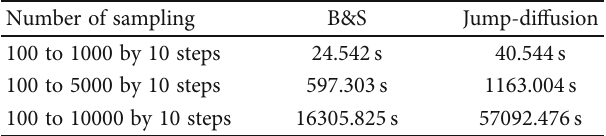
Table 2: Time consumption (MATLAB R2019a program). Number of